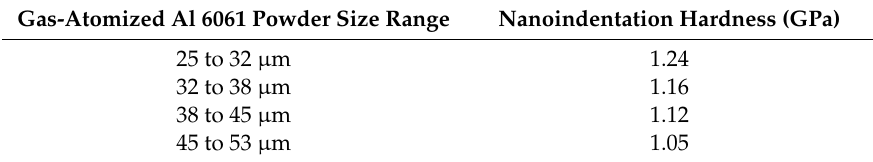
Table 3. The average nanoindentation hardness values as a function of sieve size range are presented for Al 6061. gas-atomized powder herein. Note that the decreased hardness associated with particle size for Al 6061 is not universal since other microparticles undergo solidification-based undercooling, for example, which e ff ects the resultant microstructure of a